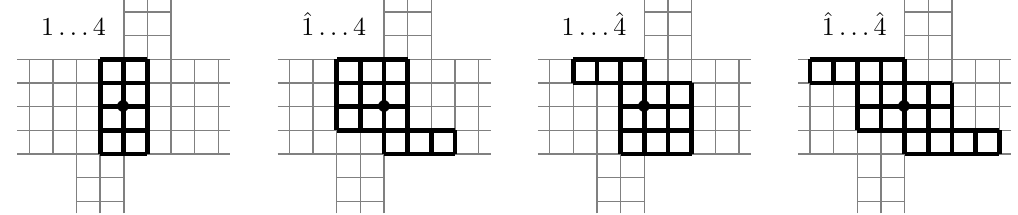
Figure 2 . Young diagrams for the four short multiplets that constitute the Konishi multiplet. The given gradings are those where the operators in the short multiplets remain highest weight states at (cid:12)nite